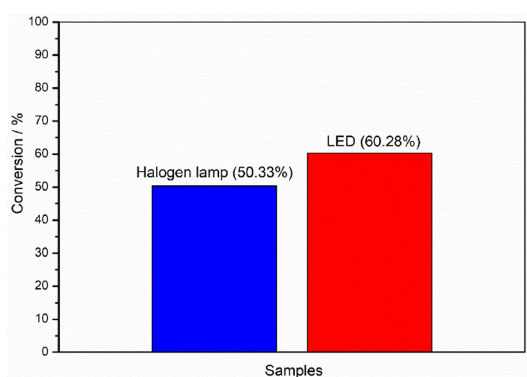
Figure 4. MC (%) values for each sample after 10 s of